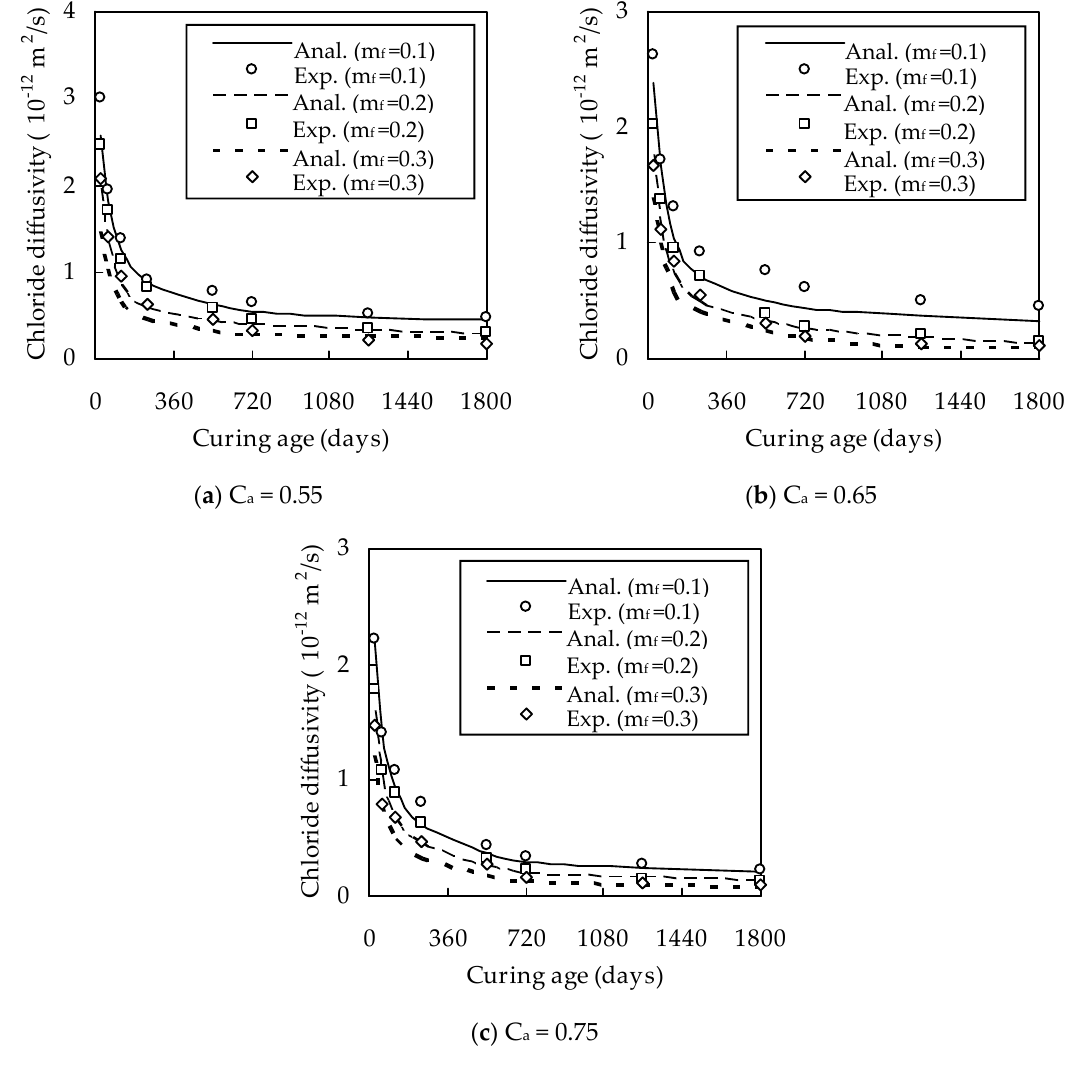
/ b = 0.4. cf with t for w